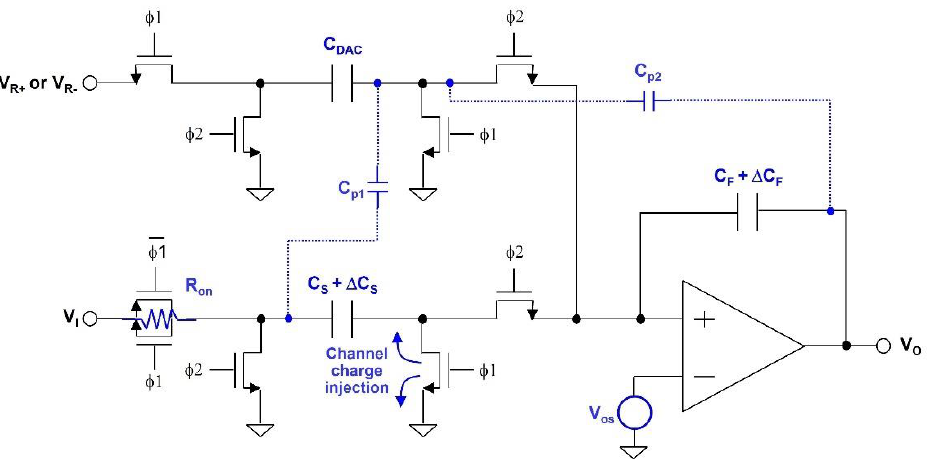
Figure 6. Concept of SC integrator macro model.